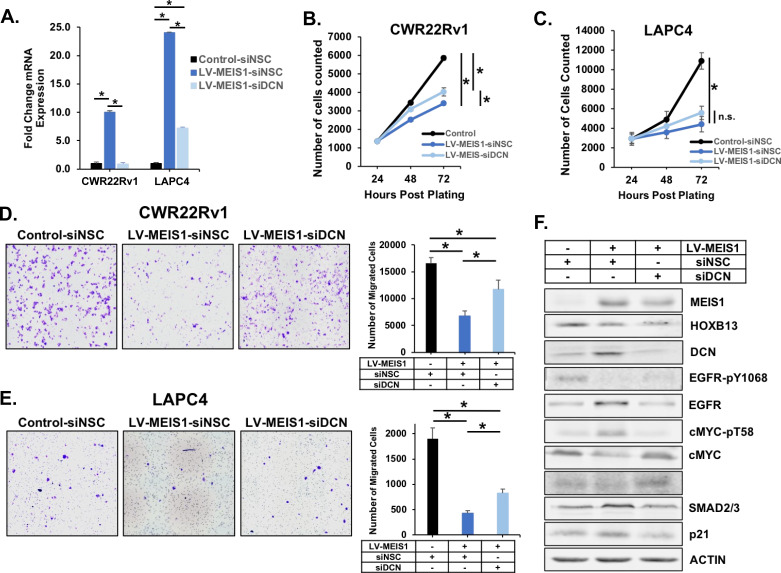
Knockdown of DCN partially reverses MEIS-mediated tumor suppression.(A) RT-PCR in both CWR22Rv1 and LAPC4 for DCN expression in control (black) and LV-MEIS1 (dark blue) cells treated with a non-silencing control siRNA pool (siNSC, 4 siRNAs in pool) or LV-MEIS1 cells treated with an siRNA pool targeting DCN (light blue) (siDCN, 4 siRNAs in pool). Fold-change from control-siNSC was calculated using ΔΔCq methodology (technical replicates, n = 3). *Student’s t-test p<0.05. (B-C) Proliferation of CWR22Rv1 (B) and LAPC4 (C) cell lines from (A) was assessed using CyQuant direct cell proliferation assay. Data represent mean and SEM at each timepoint (technical replicates, n = 3). (D-E) Representative 10X images (left) and quantitation (right) of transwell migration assay for CWR22rv1 (D) and LAPC4 (E) cell line derivatives (control-siNSC, LV-MEIS1-siNSC, LV-MEIS1-siDCN). Data represent mean and SEM (technical replicates, n = 3). (F) Western blot analysis of MEIS1, HOXB13, DCN, and known downstream targets of DCN in CWR22Rv1 control-siNSC, LV-MEIS1-siNSC, and LV-MEIS1-siDCN. *Student’s t-test p<0.05 for all panels. See also Figure 5—figure supplement 2.